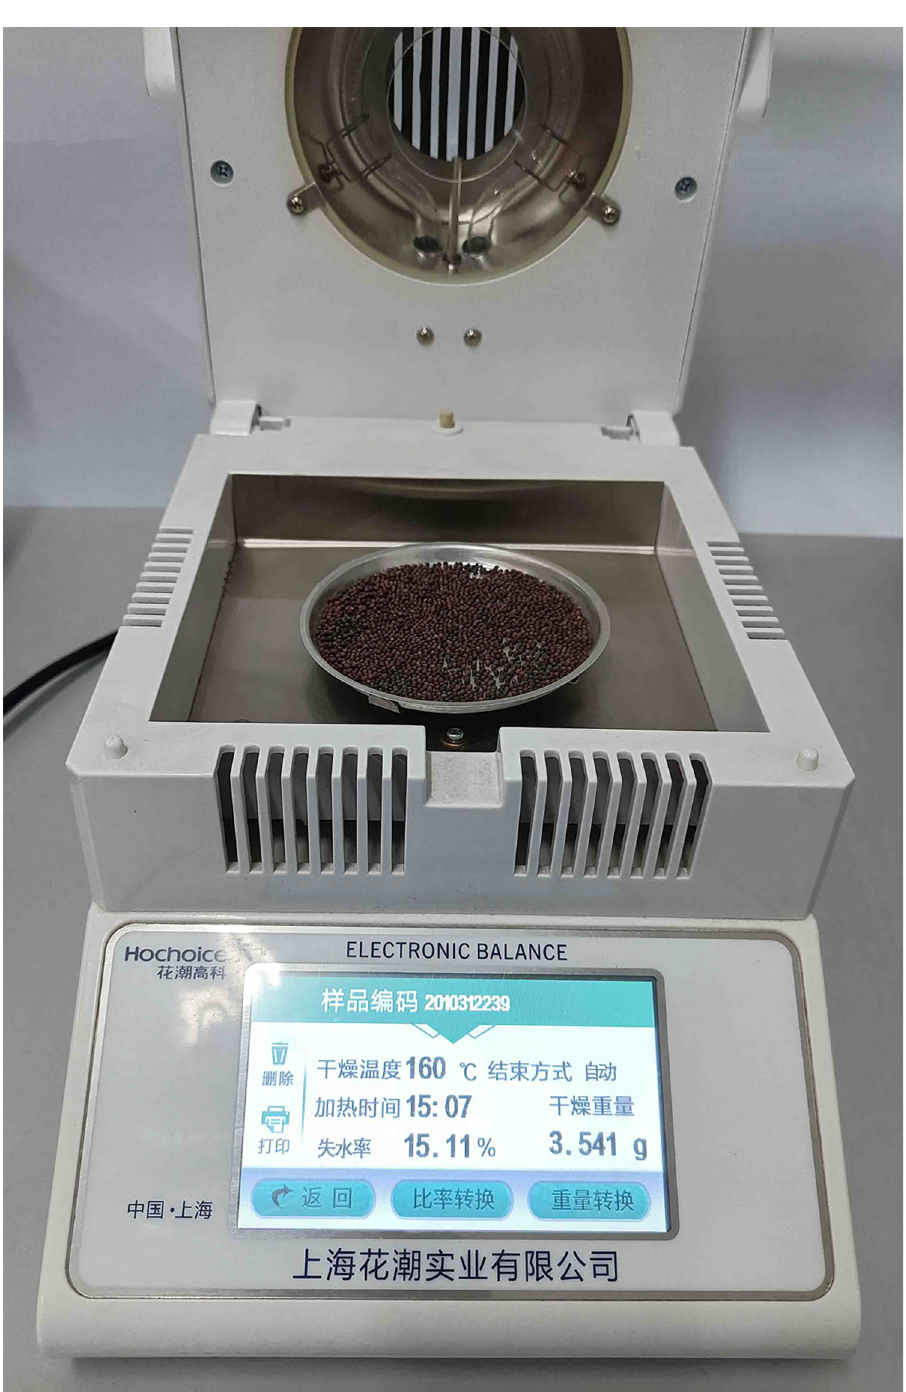
Fig 1. Determination of moisture content of Chinese cabbage